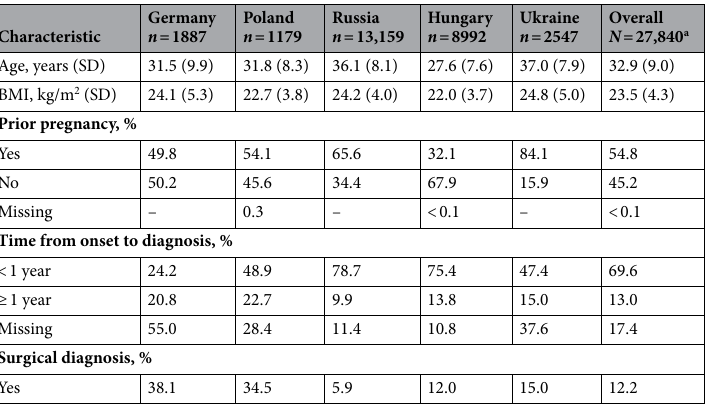
Table 1. Baseline patient characteristics and demographics of women enrolled in VIPOS. a Patients from Switzerland are not presented here as a subcategory owing to low patient numbers ( n = 74). BMI body mass index, SD standard